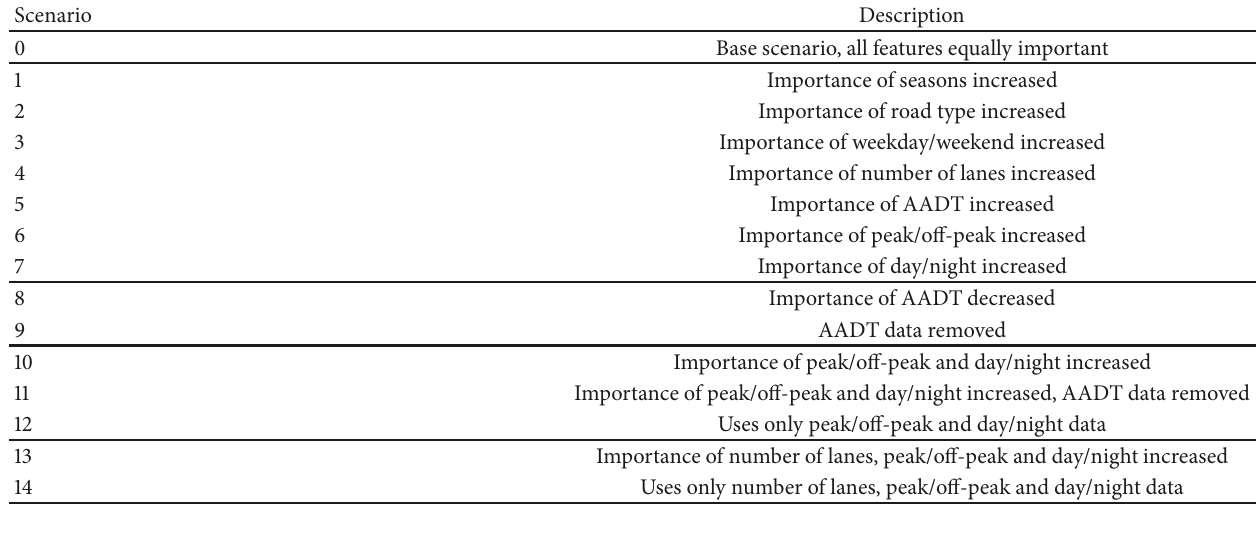
Table 4: List of tested scenarios.